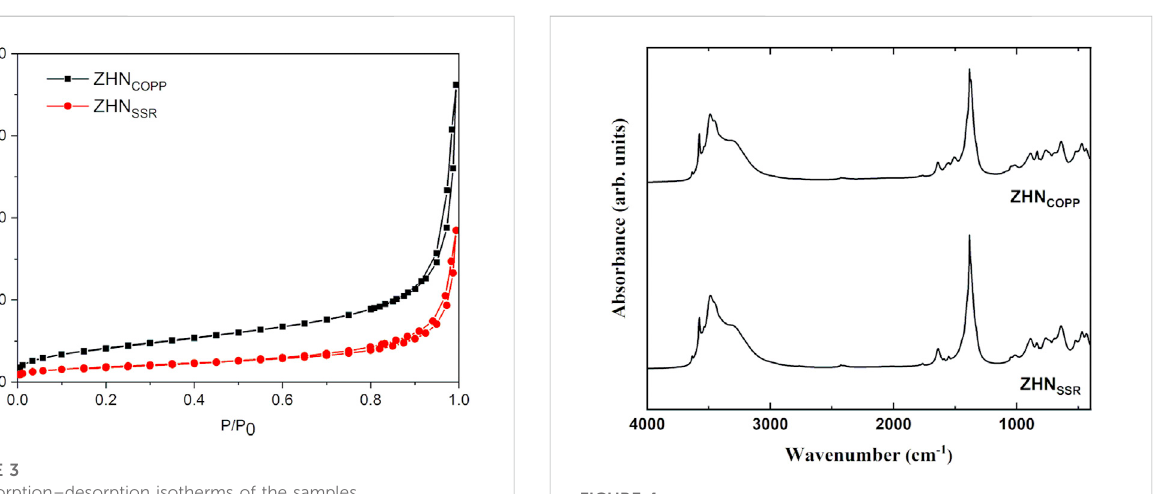
FIGURE 4 Infrared spectra of the ZHN COPP and ZHN SSR